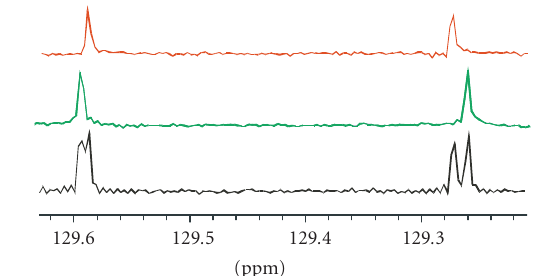
Figure 2: Overlaid 13 C-NMR spectral sections of olefinic carbons of PCs with MOFAs (top OPPC, middle POPC, and bottom